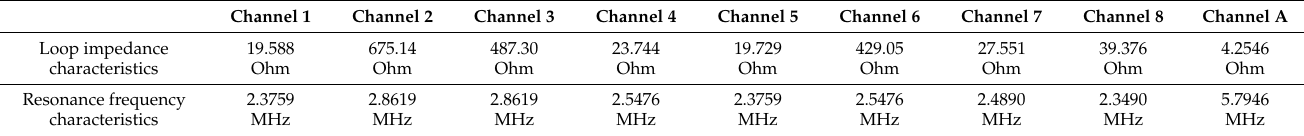
Table 1. Comparison of resonance frequency conditions between Channels 1–8 and Channel A. Channel